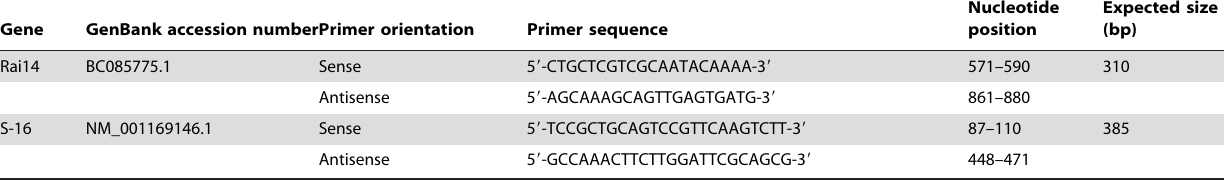
Table 2. Primers used for